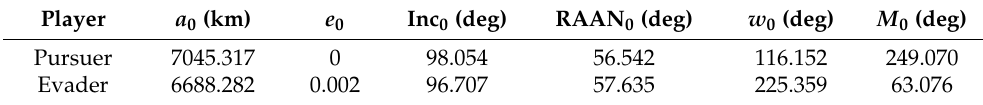
Table 3. The initial orbits of the pursuer and evader in case